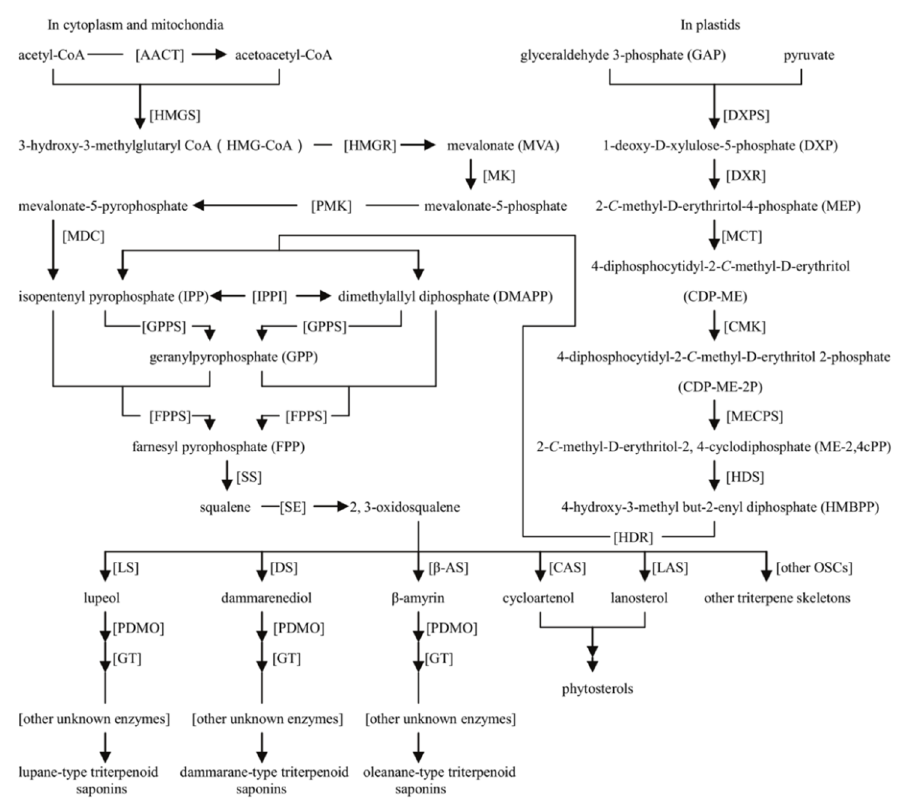
Figure 1. Biosynthetic pathway of triterpenoid in higher plants. Abbreviations: AACT: acetyl CoA: acetyl CoA C-acetyltransferase or acetoacetyl-CoA thiolase; CAS: cycloartenol synthase; CMK: